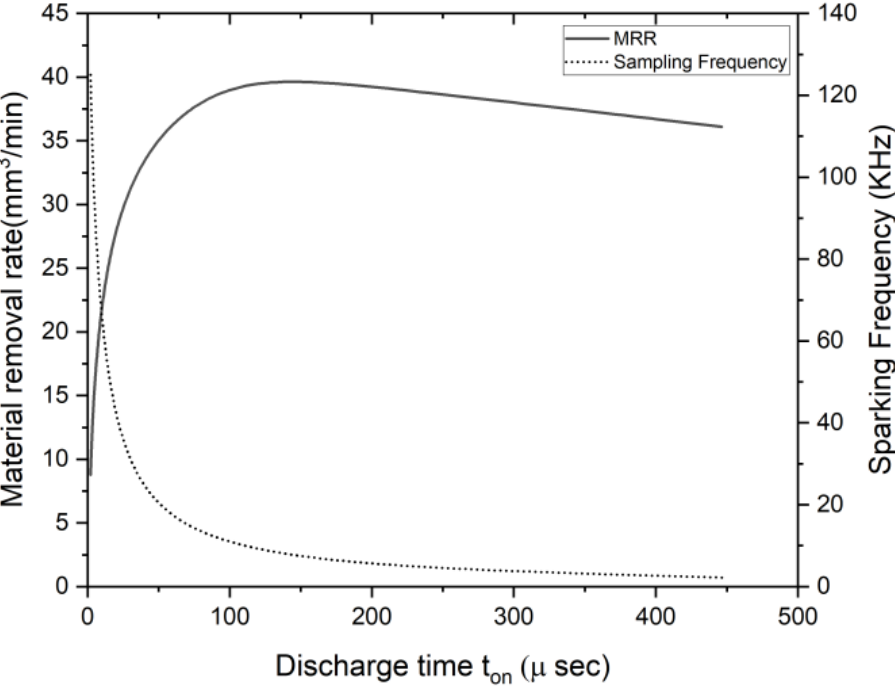
Figure 5. Non-linear MRR and spark frequency against the discharge time.